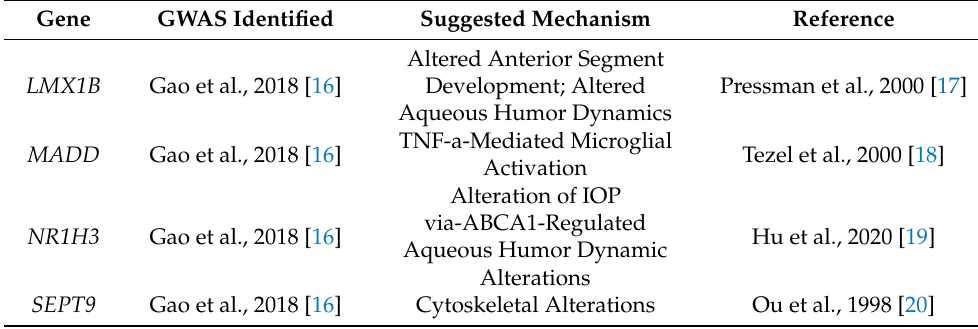
Table 1. Selection of genes associated with IOP and suggested molecular